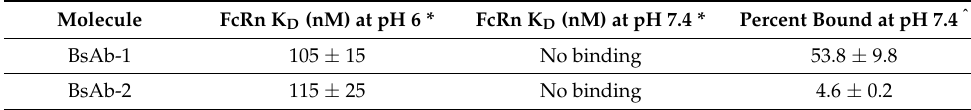
Table 2. FcRn Interaction Properties of the BsAbs.